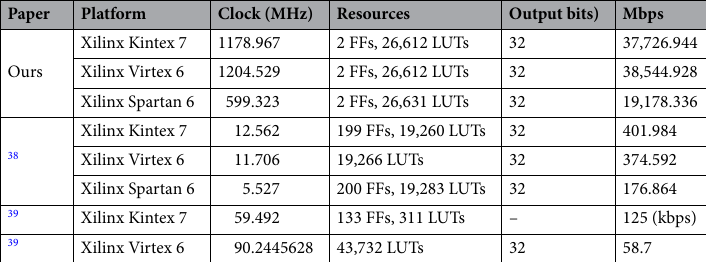
Table 4. Performance comparison between the proposed system to other systems.